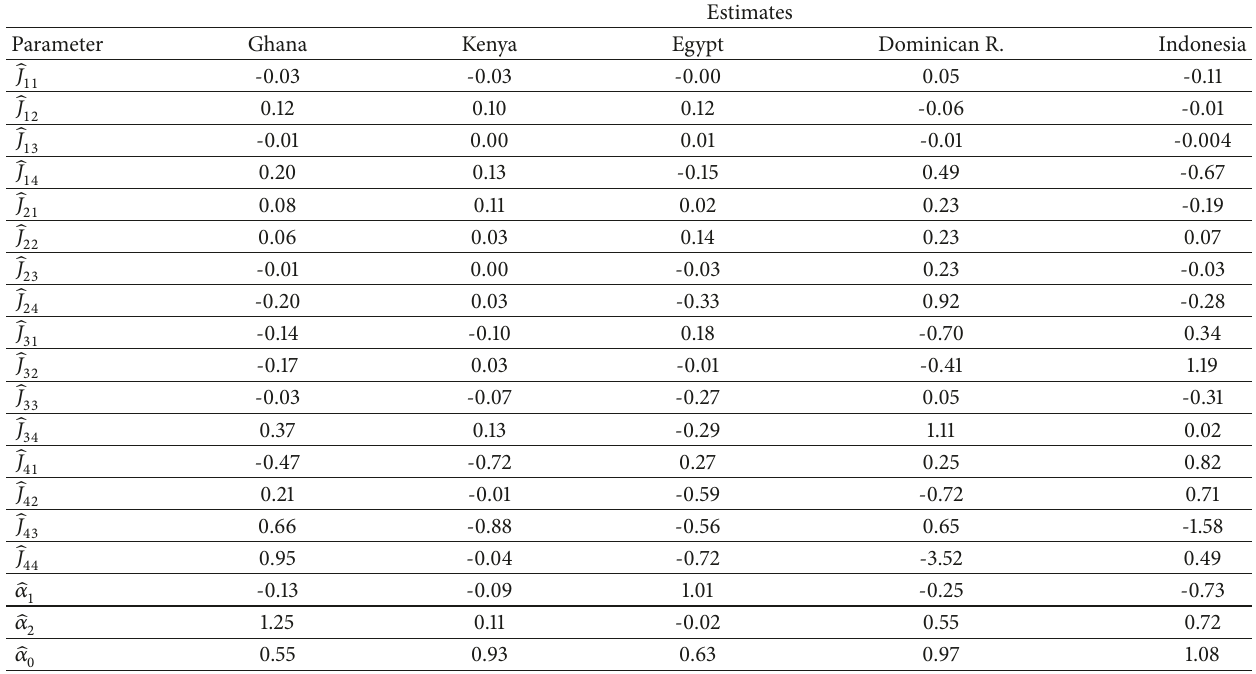
Table 2: Educational Attainment: Estimates for the interacting model.